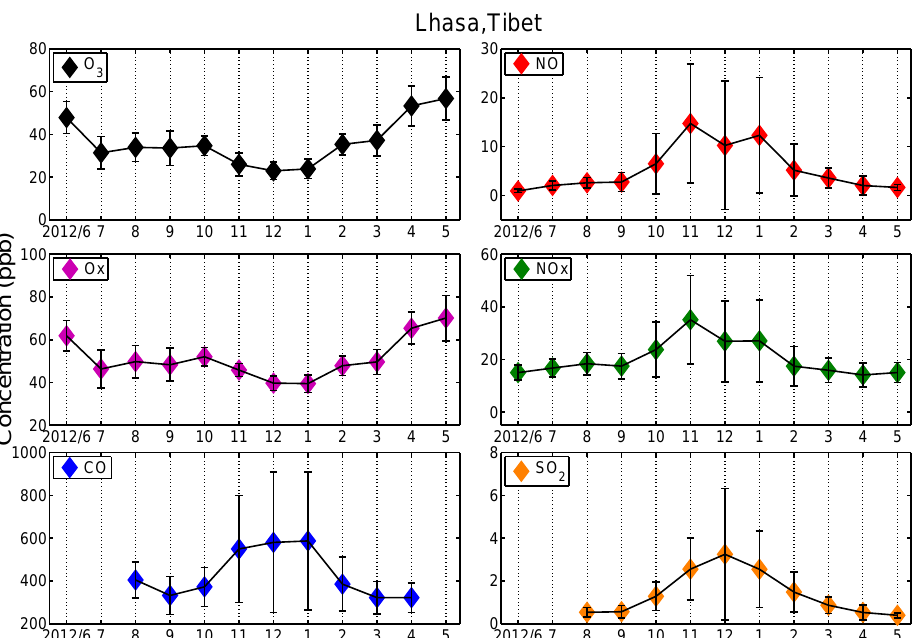
Figure 4. Monthly averages (markers) and standard deviation (black lines) of gas pollutants in Lhasa from June 2012 to May 2013.